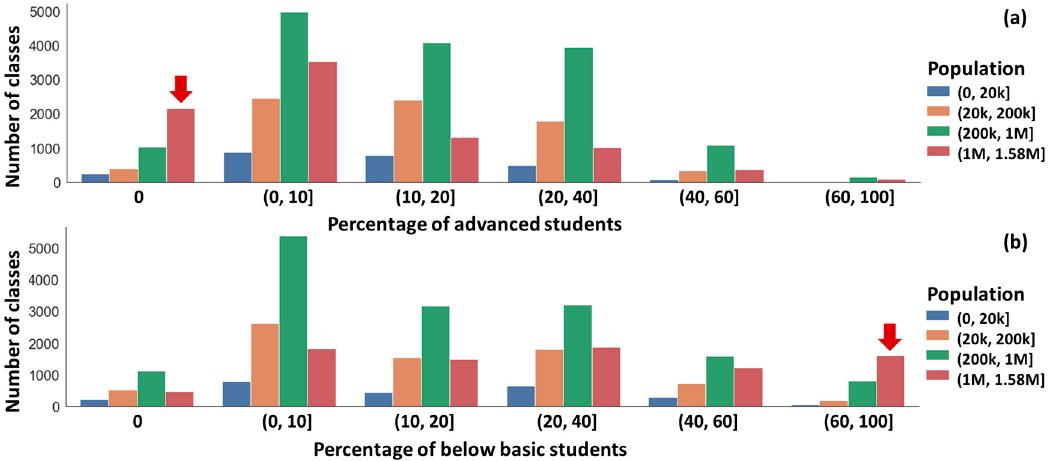
Figure 3. Analysis of the relationship between county population and academic performance; ( a ) percentage of advanced students; ( b ) percentage of below basic students. The red arrows indicate the highest population in the county, which are the groups specifically analyzed.